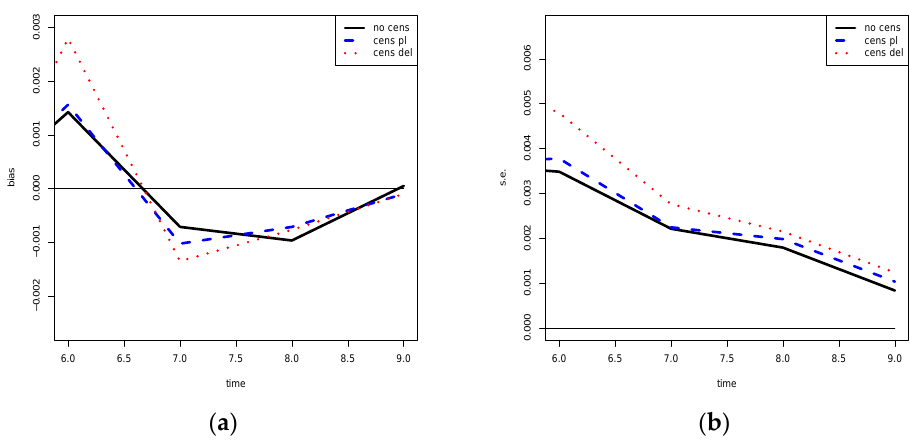
Figure 2. Bias ( a ) and standard ( b ) error for each of the three estimators. Examining the plot of the results in Figure 2b, we note that the standard errors decrease with time. This is due to the fact that the variance of the recovery rate of the simulated single loan decreases with time. Comparing the curves in Figure 2, we see that the lines corresponding to the “no cens” estimator (black solid line) and the “cens pl” estimator (blue dashed line) are overlapping at any time 𝑡 < 7 and with slight differences in the last years, for the effect of censoring. The line corresponding to the “cens del” estimator (red dotted line) is very different displaying a higher bias and standard error.